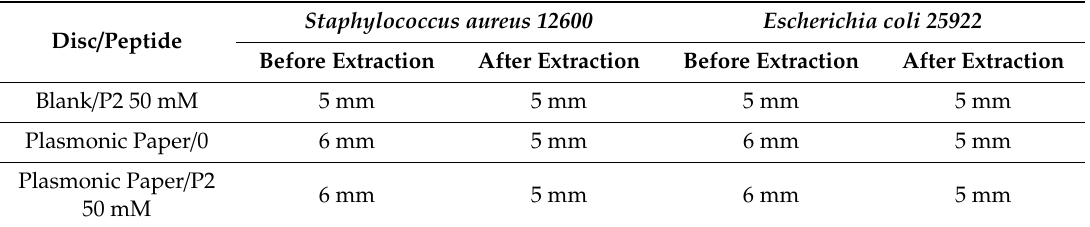
Table 1. Comparative antimicrobial activity of the di ff erent disc combinations before and after extraction of antimicrobial active components expressed by the diameter of